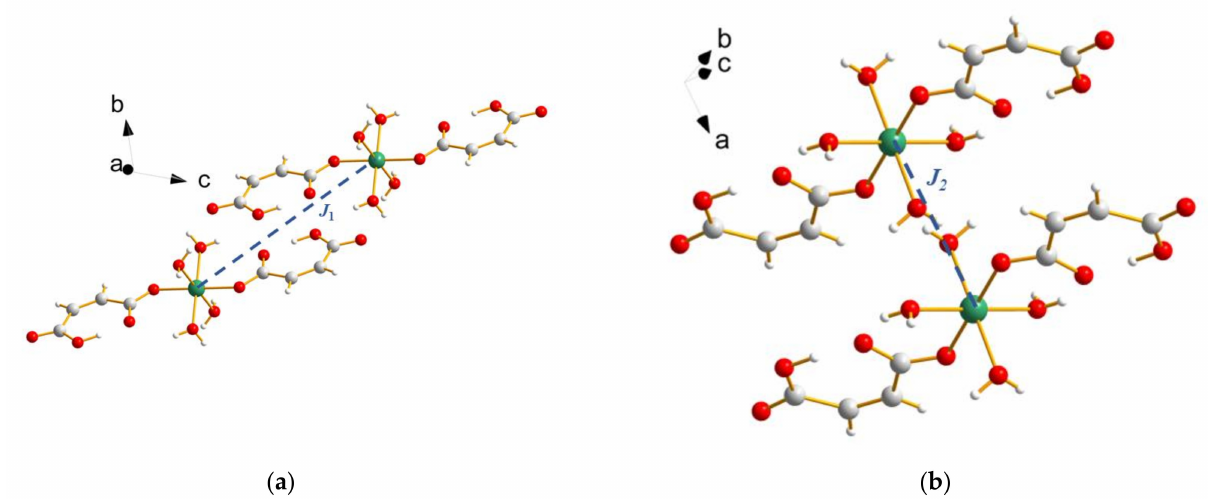
Figure 7. Schematic representation of the J1 ( a ) and J2 ( b ) exchange interactions in the crystal structure of NiHmal.